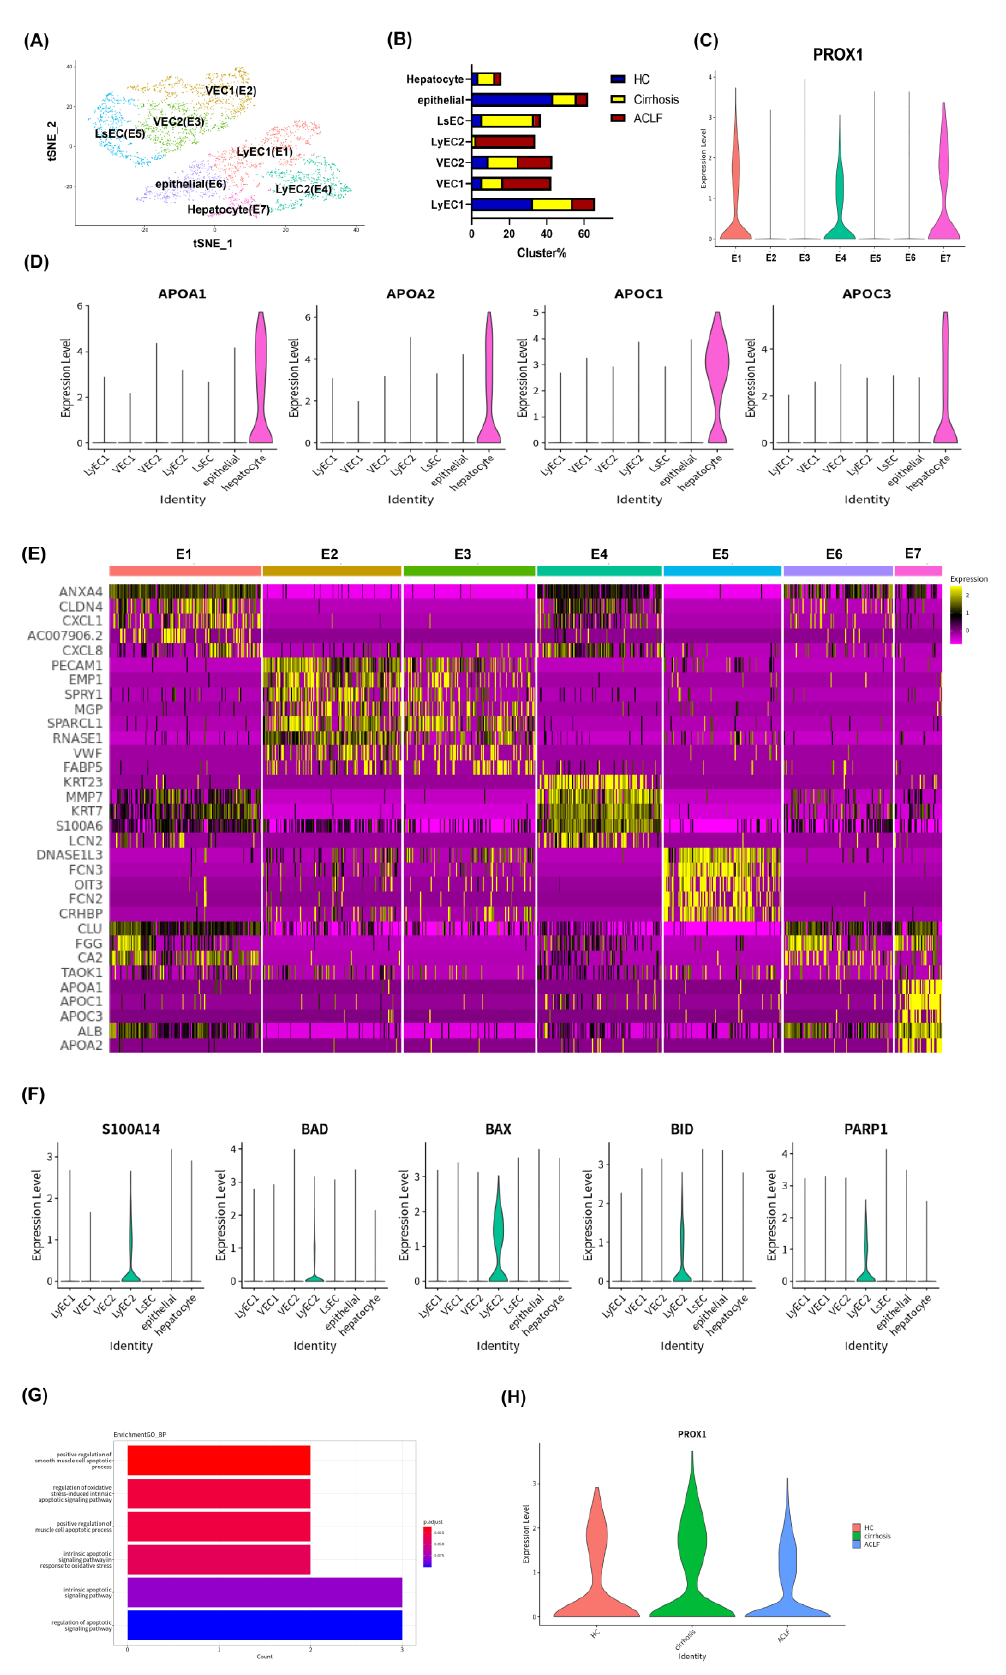
Figure 3. scRNA-seq revealed apoptosis and dysfunction of LyECs in the liver of ACLF patients. ( A ) 3769 Epithelial/endothelial cells from HCs ( n = 2), cirrhosis patients ( n = 3), and ACLF ( n =